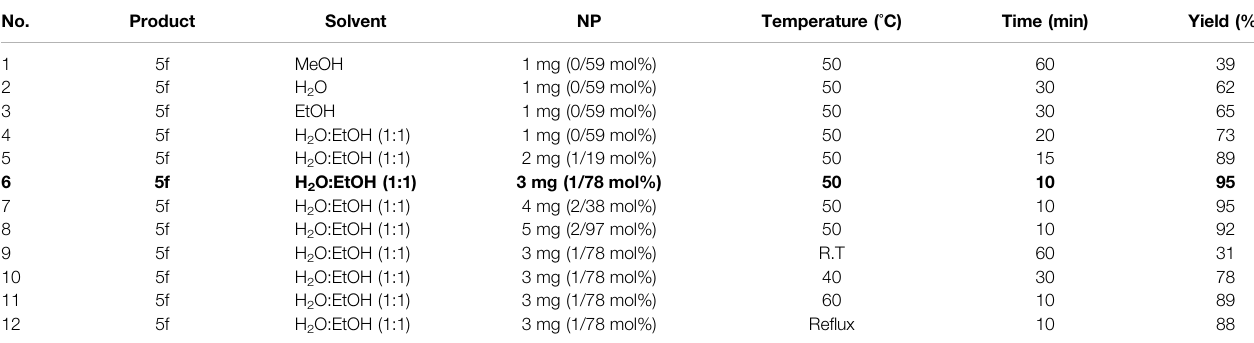
TABLE 2 | Optimization of solvent, amount of catalyst, and temperature in the synthesis of 5f. No.